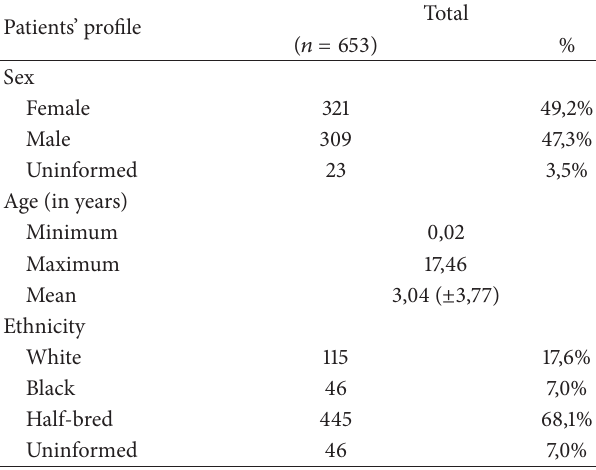
Table 1: Profile of patients served in the RCP virtual clinic.